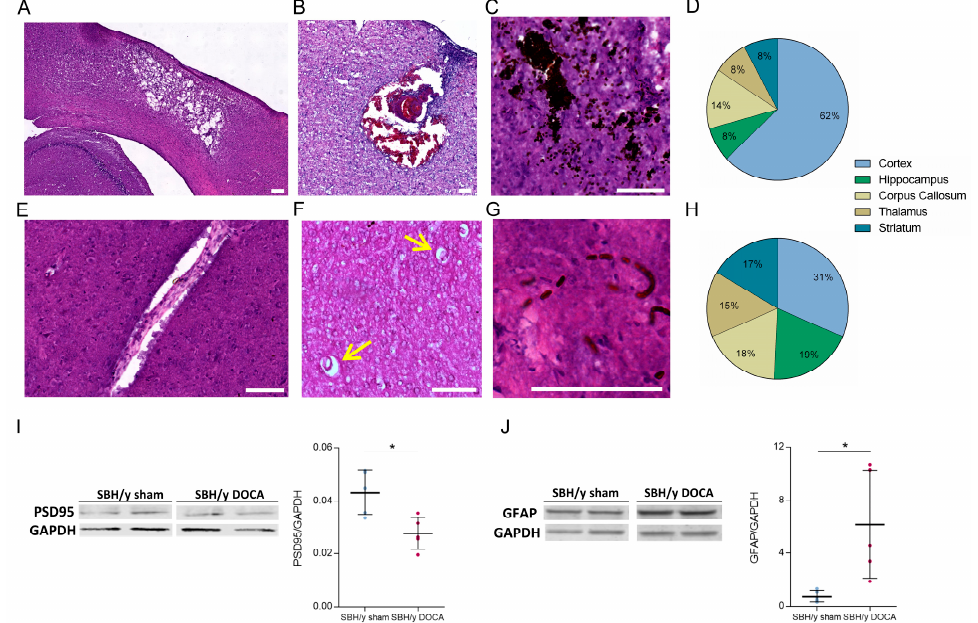
Figure 3. Pathological assessment of SBH/y-DOCA brains. H&E ( A , B , E , F ) and H&E-DAB ( C , G ) images of representative pathologies seen in brains of SBH/y-DOCA rats: Fluid-filled cavities surrounded by a spongy tissue ( A , B ), occluded vessels ( B ), ICHs ( C ), enlarged perivascular spaces ( E , F , yellow arrows) and erythrocytes accumulating in capillaries ( G ). Distribution of the occurrence of ICHs and erythrocytes accumulations throughout the brain is shown in ( D , H ), respectively. PSD95 and GFAP Western blots of protein extracted from cerebral cortices of SBH/y sham ( n = 5) and SBH/y-DOCA ( n = 5) rats are shown in ( I , J ), respectively. Scalebars = 100 µ m. Data are presented as mean ± SD, * p < 0.05, Two-tailed t